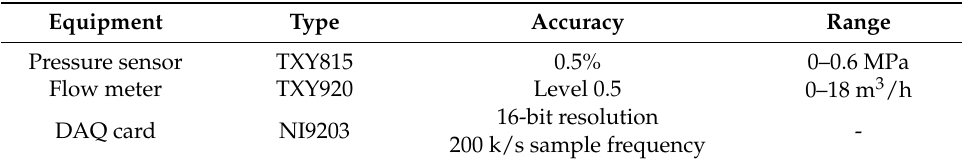
Table 1. Type, accuracy and range of experimental equipment.